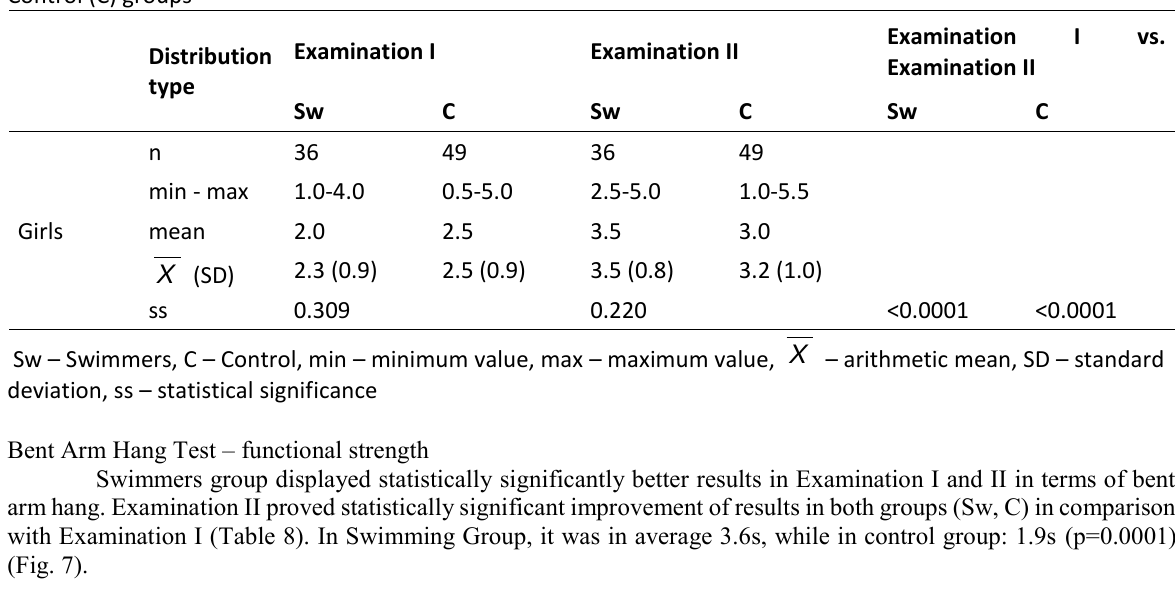
Table 6. Descriptive characteristics of Handgrip Strength Test (static strength) results in the Swimmers (Sw) and Control (C)